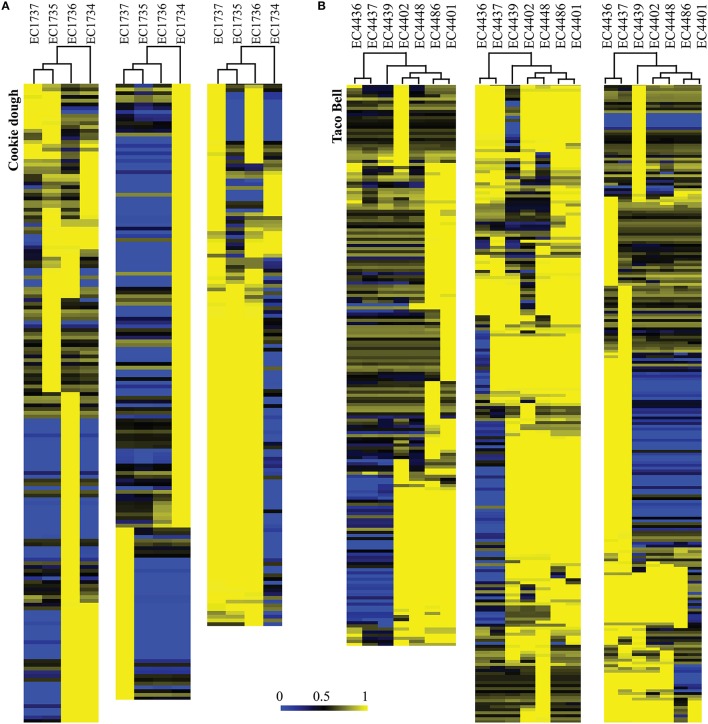
Hierarchical clustering of the computed phage variome for Cookie dough (A) and Taco Bell (B) outbreaks. Phage inventories within the respective outbreak clusters compared by LS-BSR and variome differences are presented in this heatmap. BSR values range from 0 (blue, absent) to 1 (yellow, identical). (A) Strain EC1734 contributed the majority of varying regions within the CD phage complement. (B) The tree topology derived from SNP typing for the TB outbreak (Figure 2) is in accordance with the variome clustering. Most of the variation was introduced by phages prevalent in the three temporal outlier strains EC4436, EC4437, and EC4439.